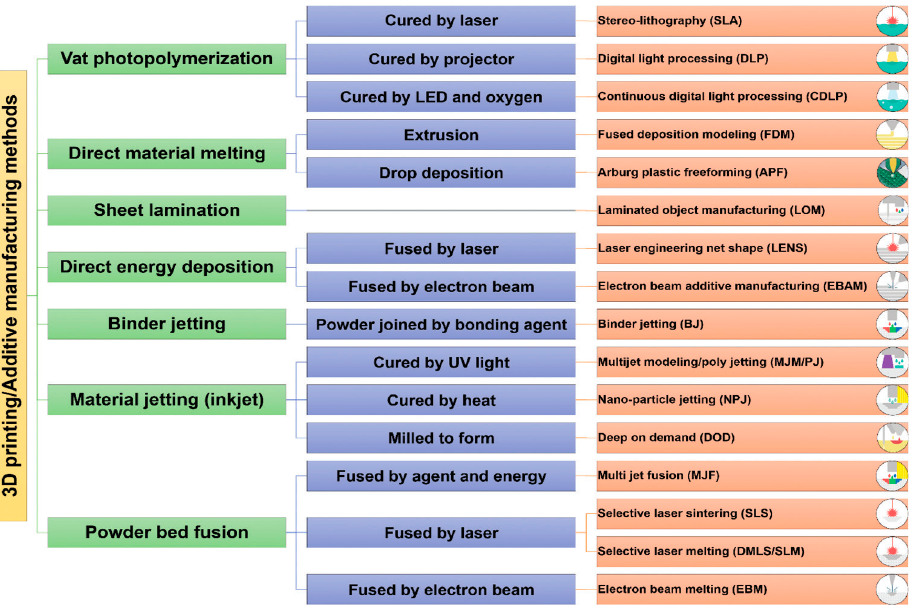
Figure 8. The most important 3DP methods and their corresponding curing and deposition systems [103].